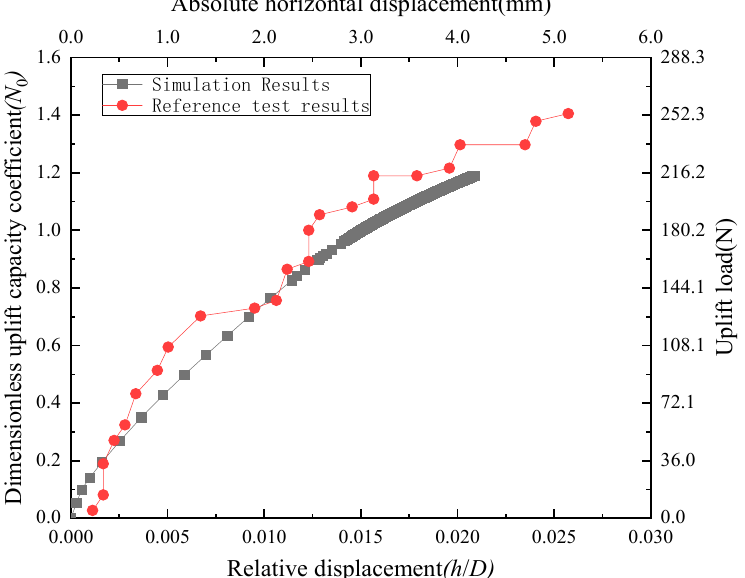
Figure 3. Comparison of finite element simulation results and experimental data of Wang et al. [25].